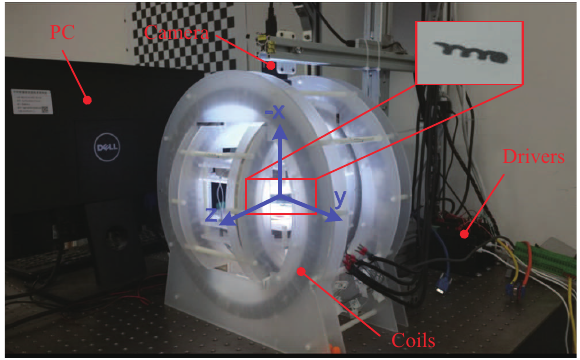
Figure 9. The 3D Helmholtz coil system